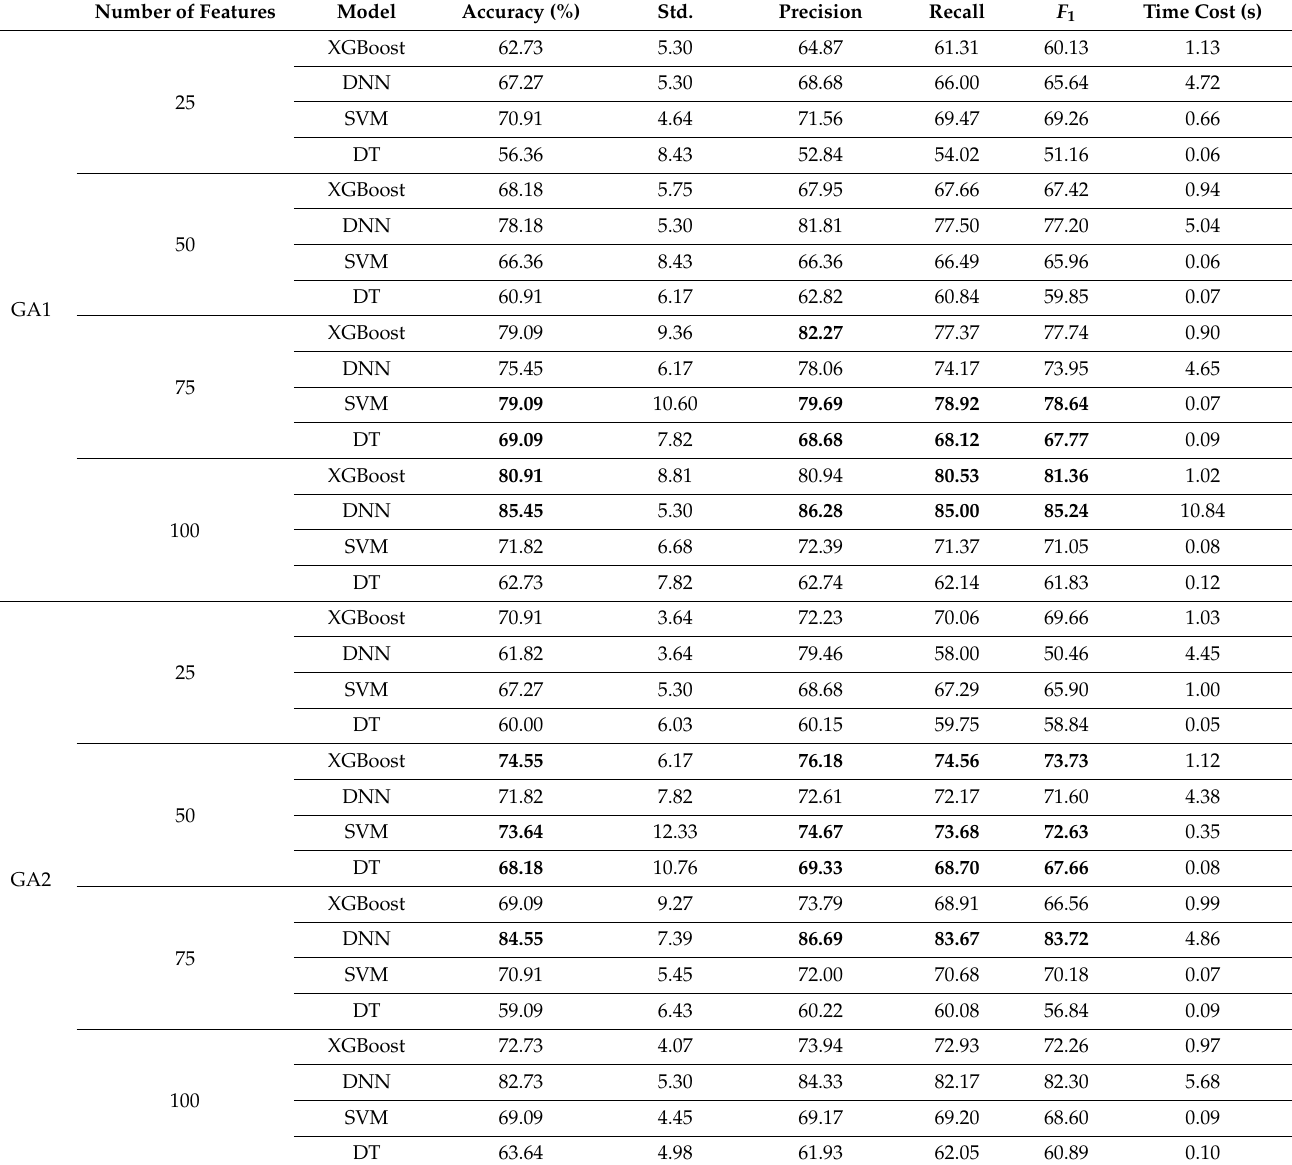
Table A1. The results of GA1 and GA2 according to the number of